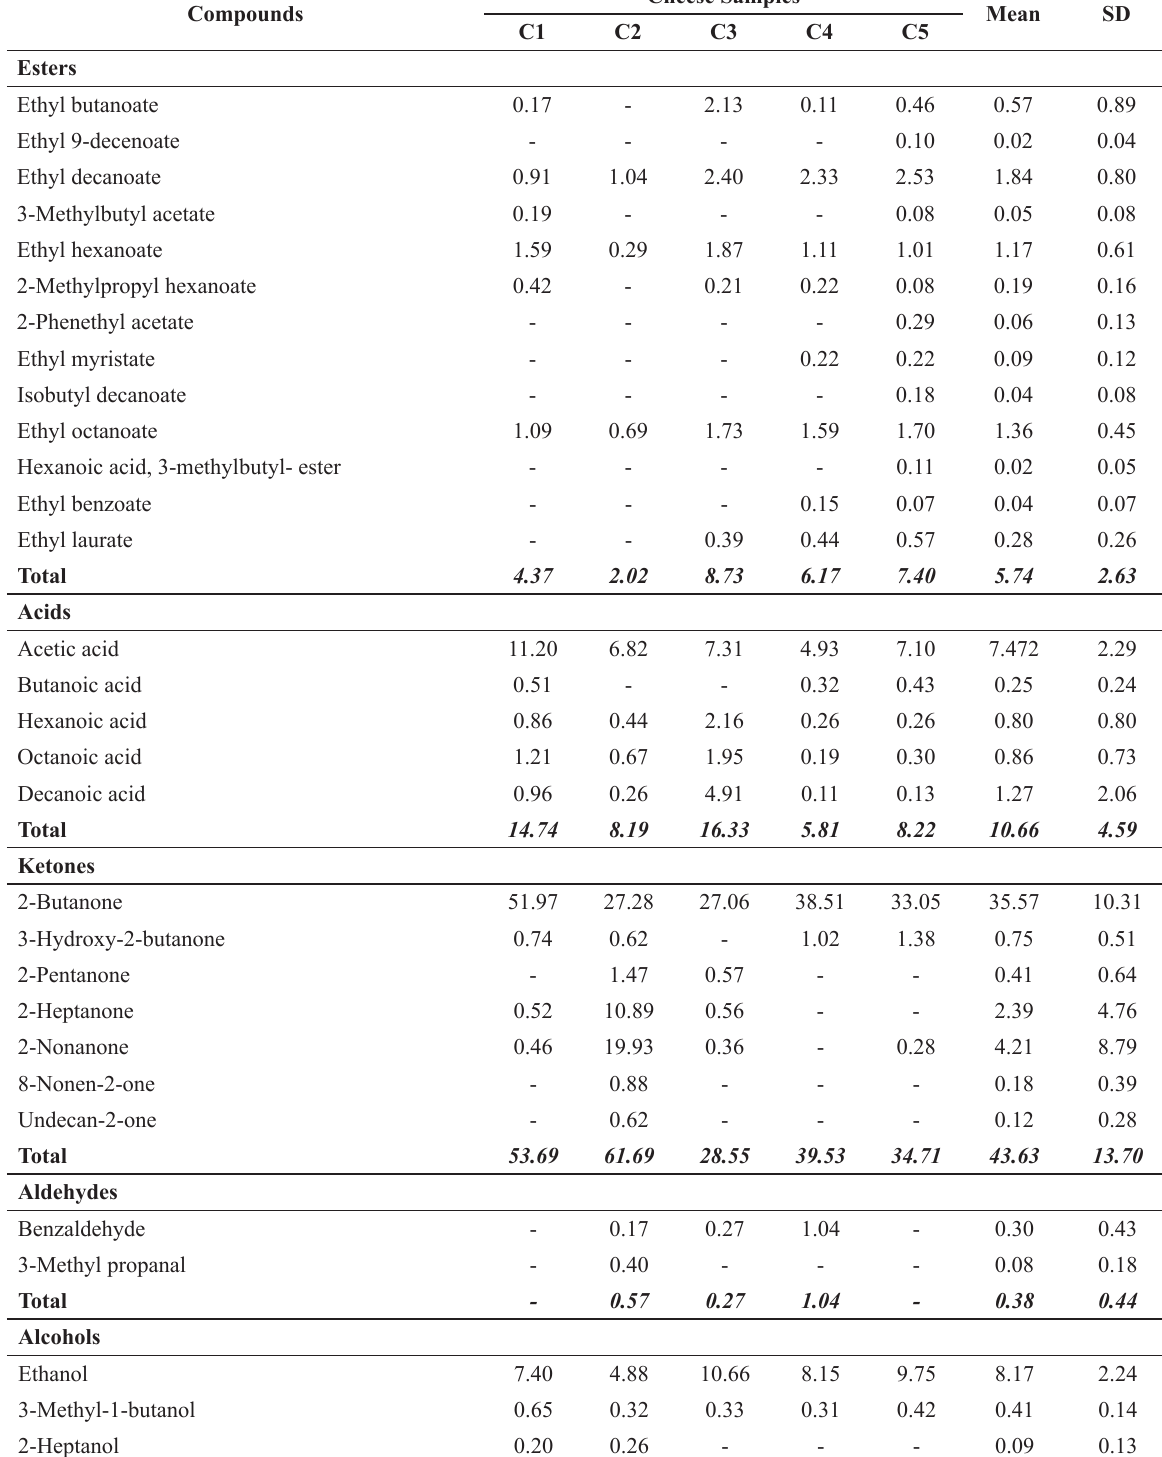
Relative abundance (%) of volatile compounds isolated from Söğle cheese samples (n =